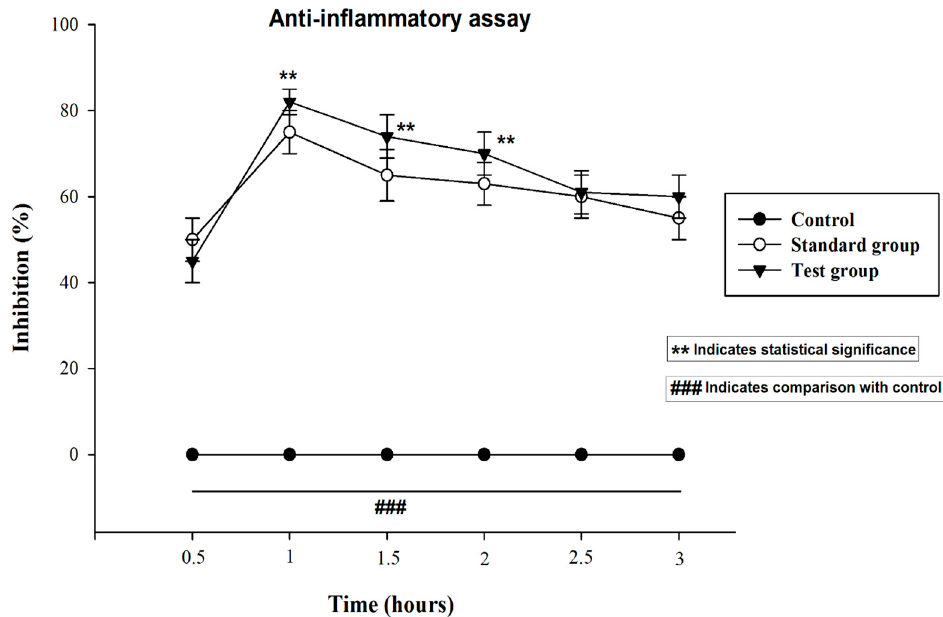
Figure 8. Anti ‐ inflammatory activity of Capsaicin nanocrystals and Dicloran ® . The control group was left untreated. Standard group was treated with marketed product Dicloran ® (Diclofenac sodium). Test group was treated with capsaicin loaded nanocrystals. The data was presented as mean ± SD and analyzed using ANOVA. ### p < 0.001 represent control, while ** p < 0.02 refers to statistical significance from the control.